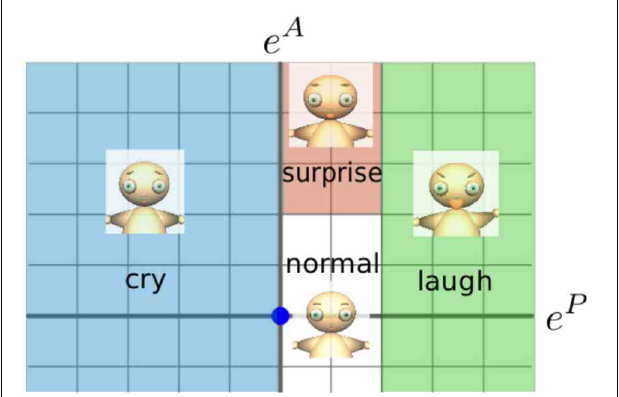
FIGURE 6 | Facial expressions and emotional states of a virtual infant agent.